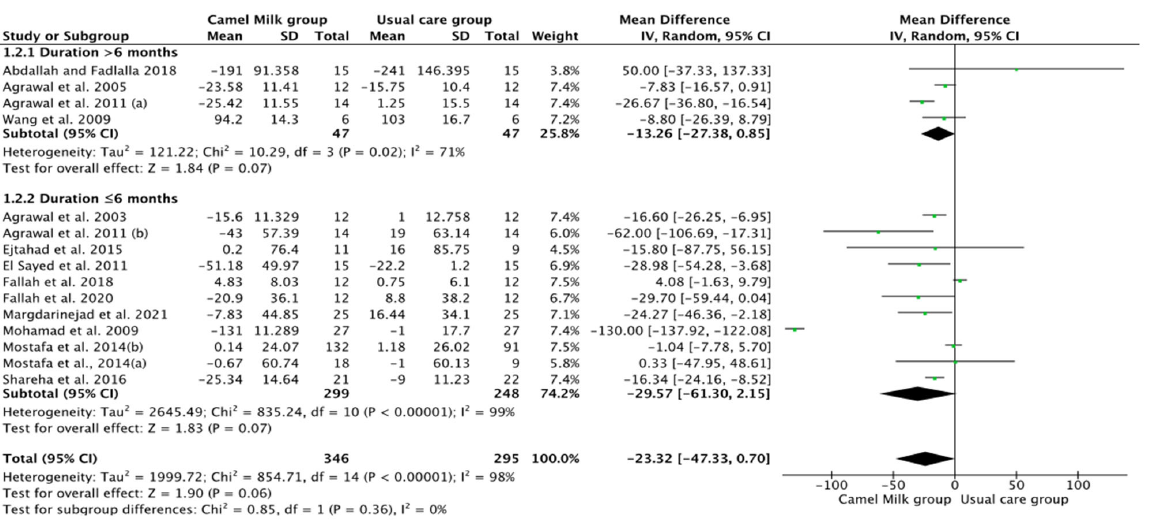
Figure 11. Forest plot for the effect of CM intake on FBG based on intervention duration. Note: Mostafa and Al ‐ Musa, 2014 (a) for T1DM and (b) for T2DM.